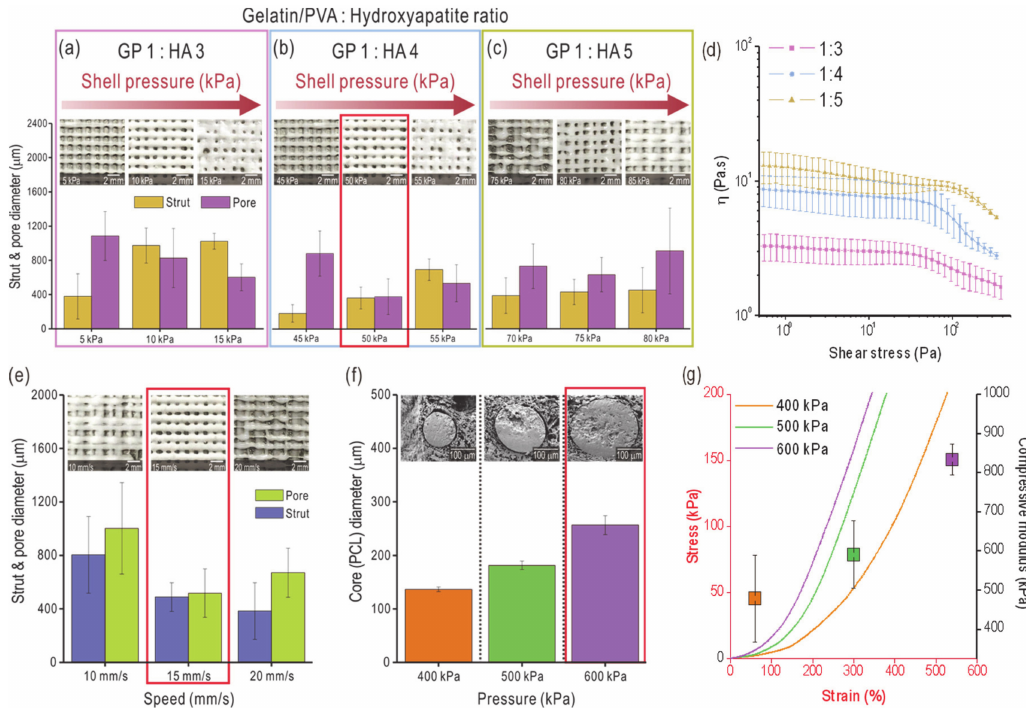
Figure 2. Printed strut and pore sizes for various pneumatic pressures and mixture ratios of gelatin / PVA (GP) and hydroxyapatite (HA) ( a ) 1:3, ( b ) 1:4 and ( c ) 1:5. ( d ) Complex viscosity ( η ) vs shear stress for various mixture ratios of GP and HA. ( e ) Strut and pore sizes for various nozzle moving speeds at a fixed mixture ratio (1:4) of GP and HA. ( f ) poly( ε -caprolactone) (PCL) diameter in the core region fabricated using a core / shell nozzle according to various pneumatic pressures applied in the core region and cross-sectional SEM images of the PCL-laden core regions. ( g ) Compressive stress-strain curves and moduli for various PCL diameters in the core region of the C-PGPH sca ff